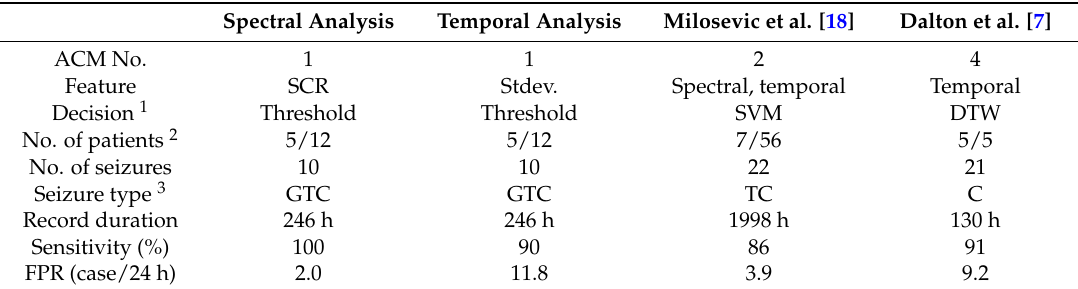
Table 3. Comparison of ACM-based seizure detection